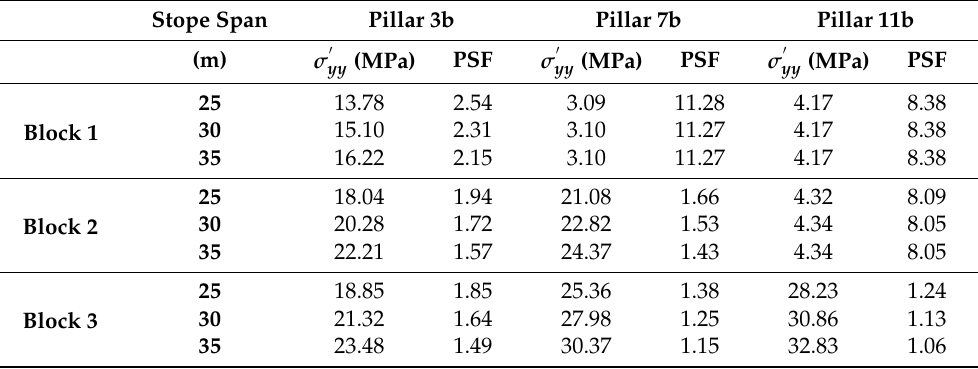
Table 1. Summary of PSF for each mining stage and stope span.